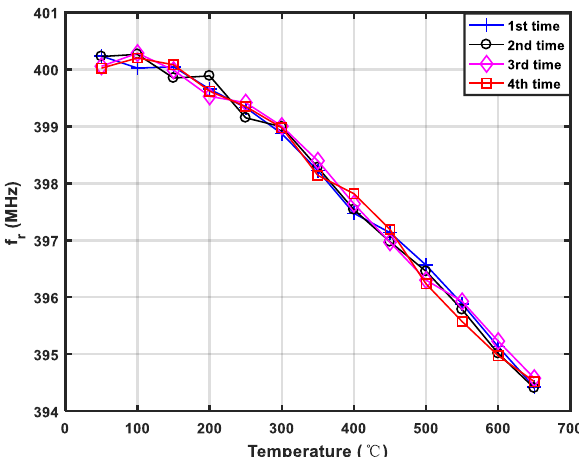
Figure 16. The measured frequency shift according to temperature (50 – 650 °C).